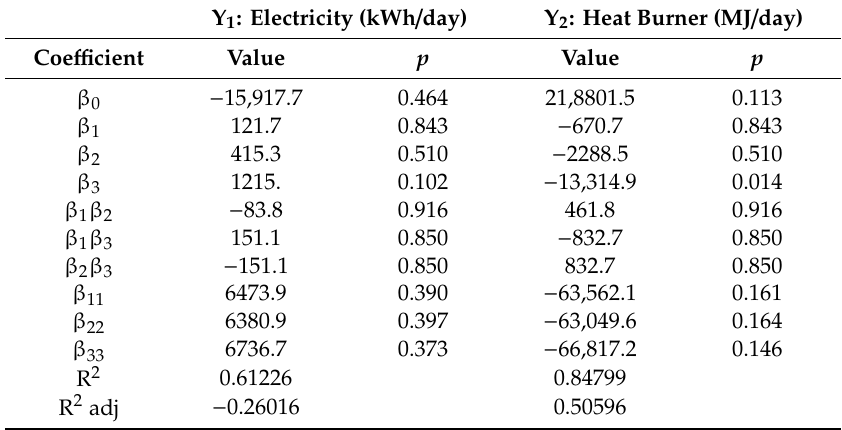
Table 7. Parameters of the polynomial model from multiple regression fitting for scenario 2. Electricity production and energy supplied to the burner to cover the thermal needs for sludge drying are the responses